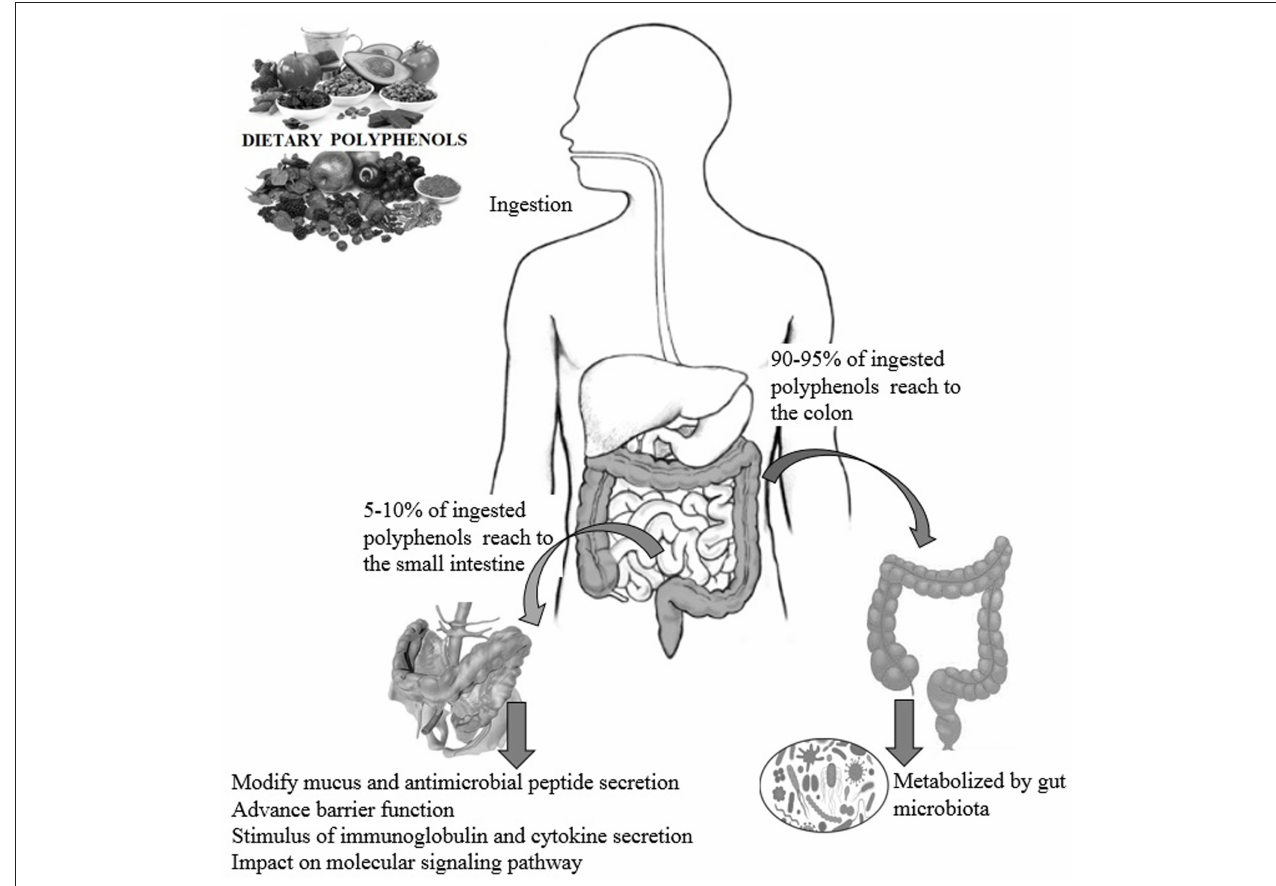
FIGURE 1 | The impact of polyphenols on gut health and the possible modes of action